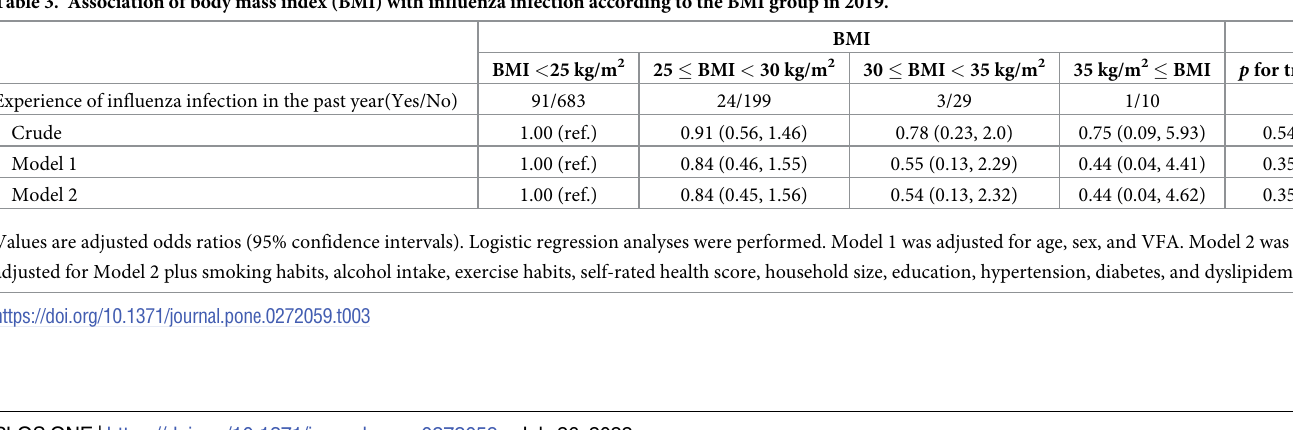
Table 3. Association of body mass index (BMI) with influenza infection according to the BMI group in 2019.